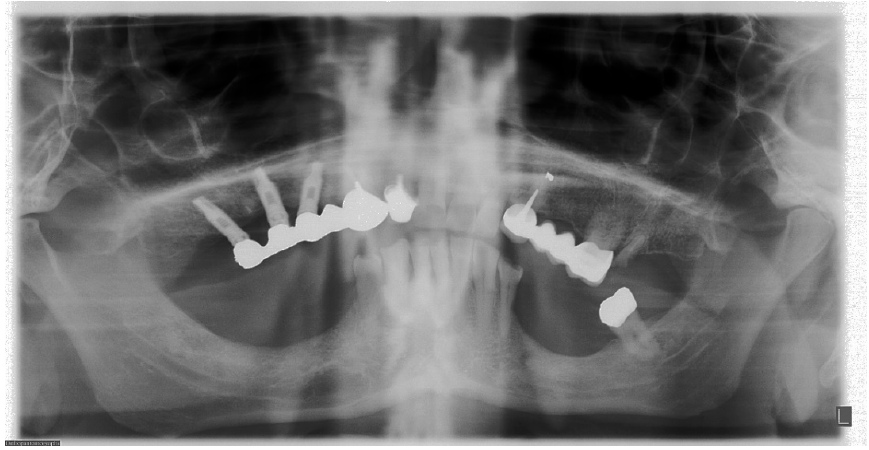
Figure 4 . Nodding up. Panoramic radiography. The occlusal plane loses the normal upper concavity and its curve is inverted. Note the radiopaque band overlapping the anterior area of both jaws.